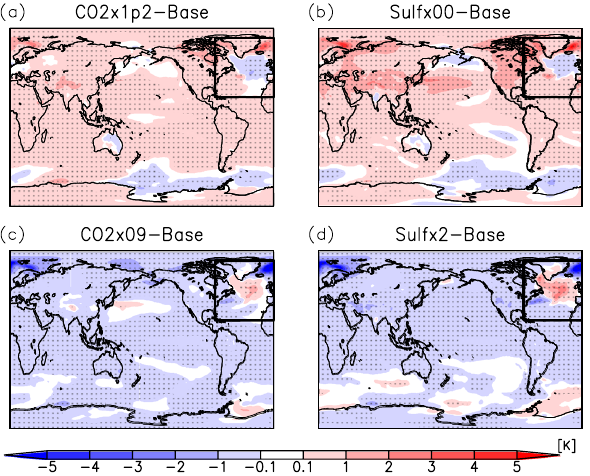
Figure 1. Anomalies of the annual mean surface air temperature for CO2 × 1p2 ( a ), Sulf × 00 ( b ), CO2 × 09 ( c ), and Sulf × 2 ( d ) experiments from the base experiment. Areas of dots indicate that the change is statistically significant. The area enclosed by the square represents the North Atlantic region defined in this study. The global mean temperature changes are + 0.32 K ( a ), + 0.41 K ( b ), − 0.28 K ( c ), and − 0.34 K ( d ), respectively. The maps were generated with GrADS 2.2.1 (URL: http:// cola. gmu. edu/